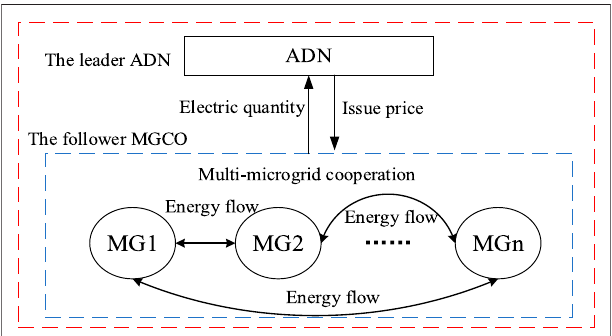
FIGURE 1 | Game scheduling framework of the ADN with the